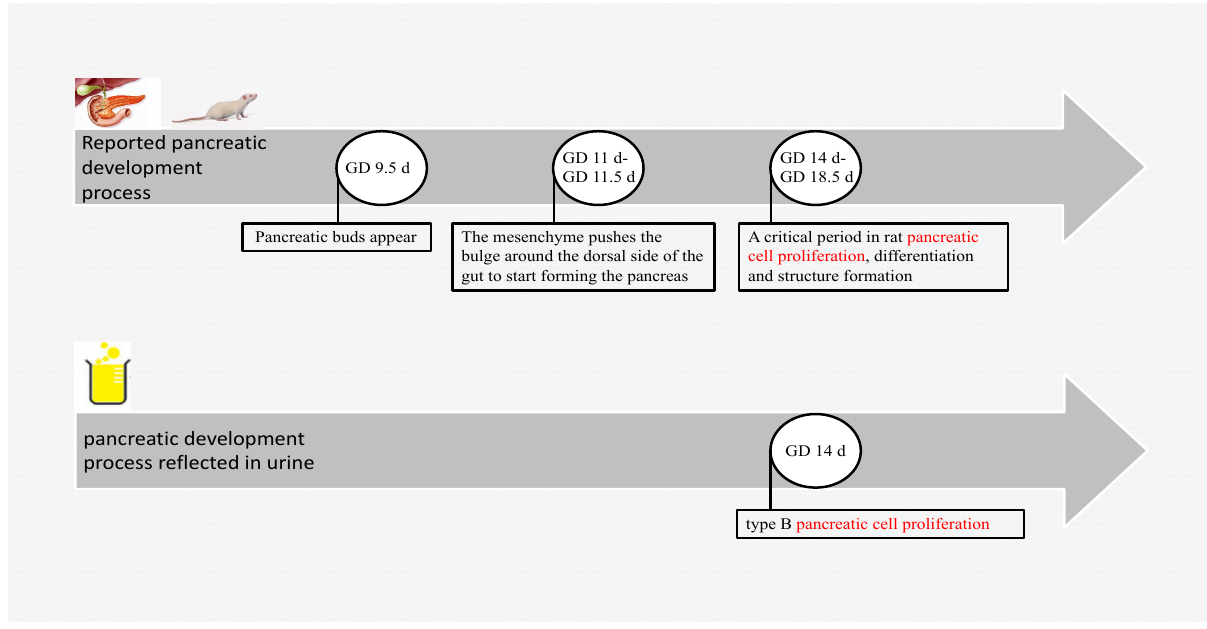
Figure 5. Fetal rat pancreas development. The above is the reported pancreatic development process. The following are pancreatic developmental processes enriched by changing urinary proteomes.